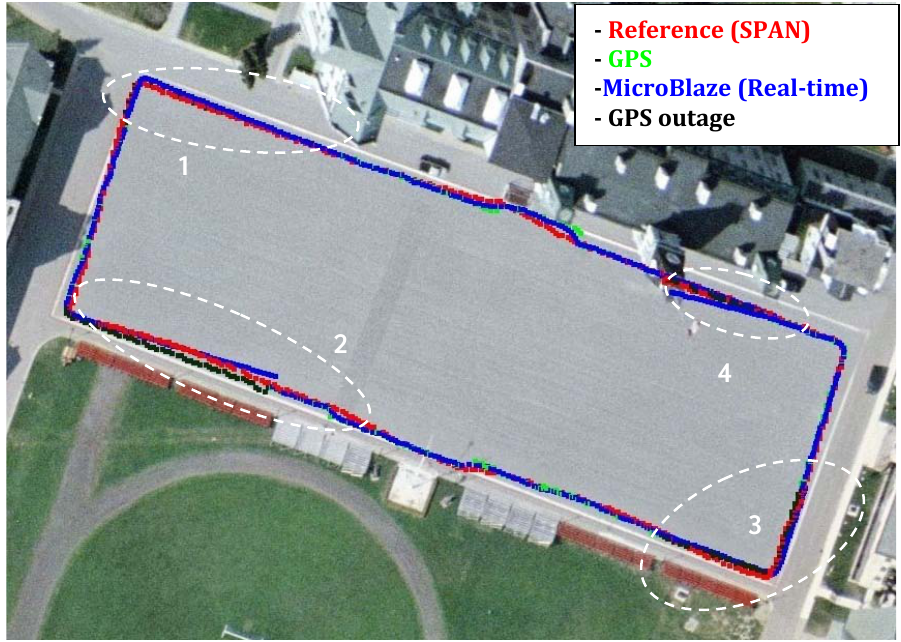
Figure 16. Mobile Robot Trajectory (2): Open Sky Area with Four Simulated GPS